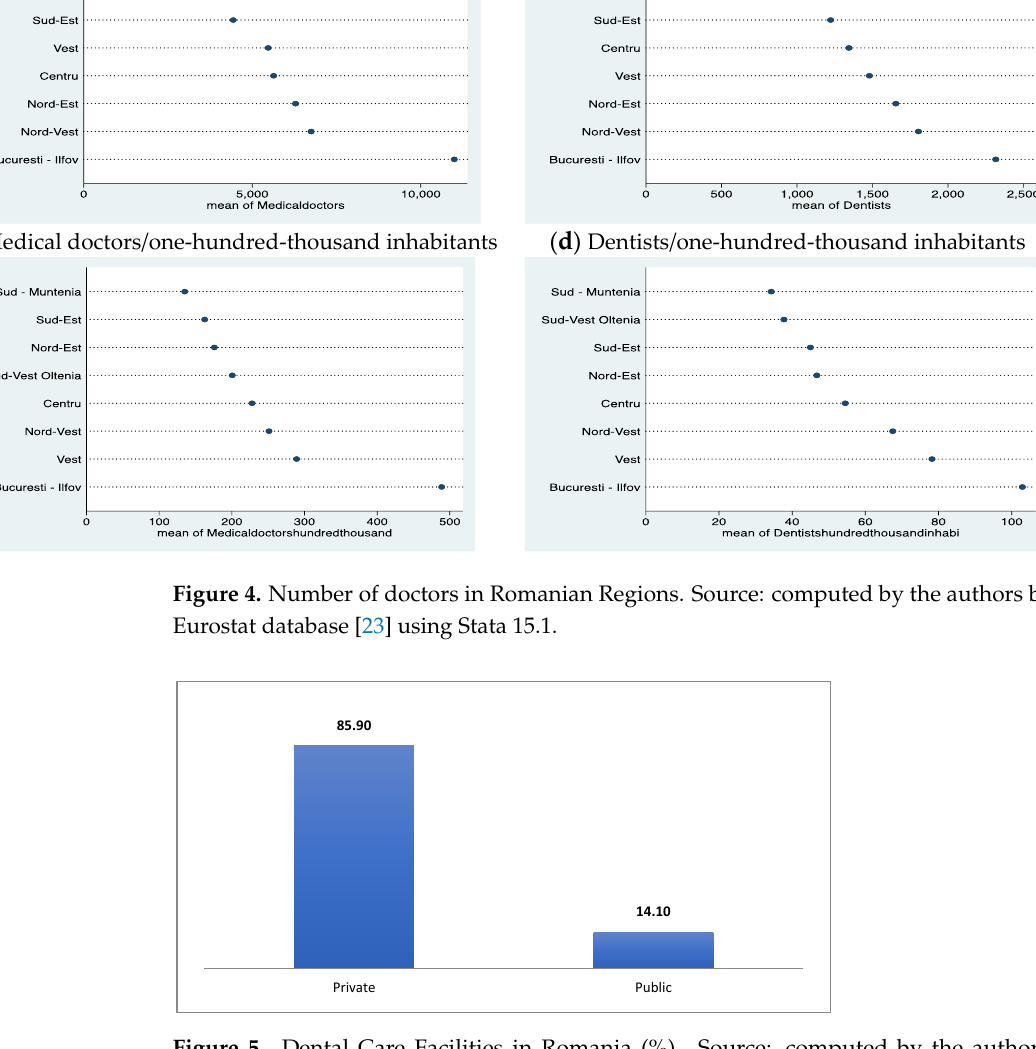
Figure 6. Dynamic of GDP per capita in Romanian regions. Source: computed by the authors based on the Eurostat database [23] using Stata 15.1.